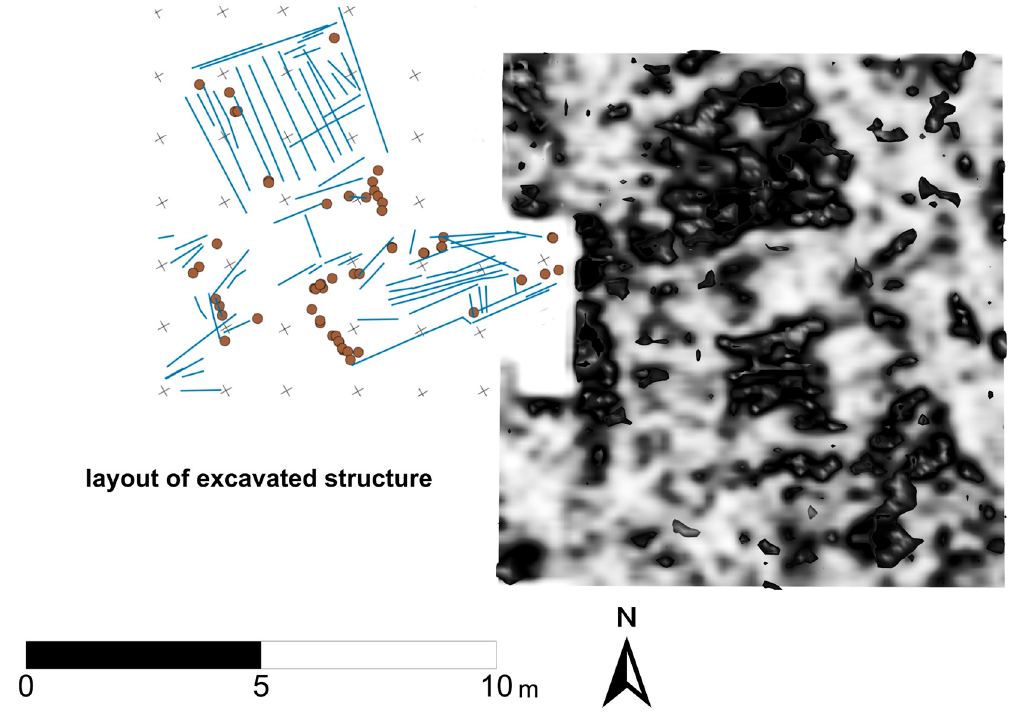
Figure 11. The relationship of the excavated structure to the unexcavated features detected with GPR. The comparative scale and alignment of the known and inferred features is obvious. The GPR image (right) is a 3-D iso-surface showing high amplitude anomalies spanning a depth of ca. 0.5–1.2 m.